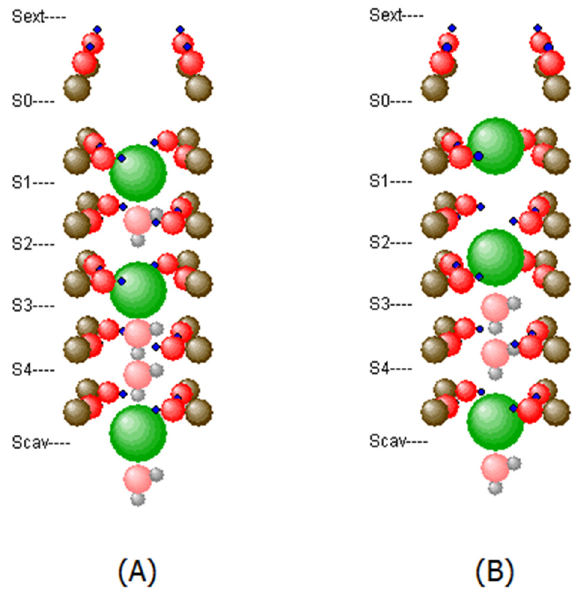
Figure 2. ( A ) Example of a filter state (K1WK3-WWKcav) which is characterized by extended sta- bility with no ion emission over periods around 100 ns; ( B ) In contrast the occupancy